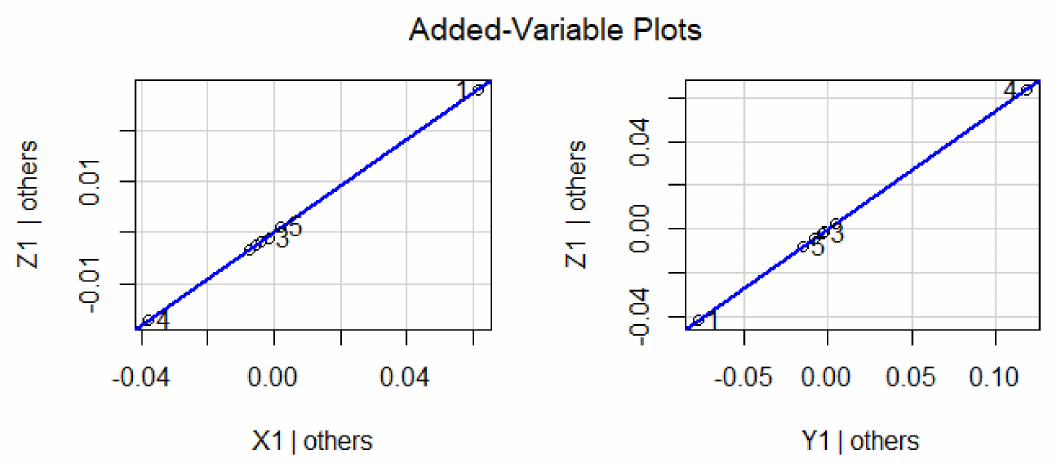
Figure 2. Data trending plot between dependent variable Z 1 and predictor variables X 1 and Y 1 with a difference of 0.02 in experimentally fixed value at 420 ◦ C.